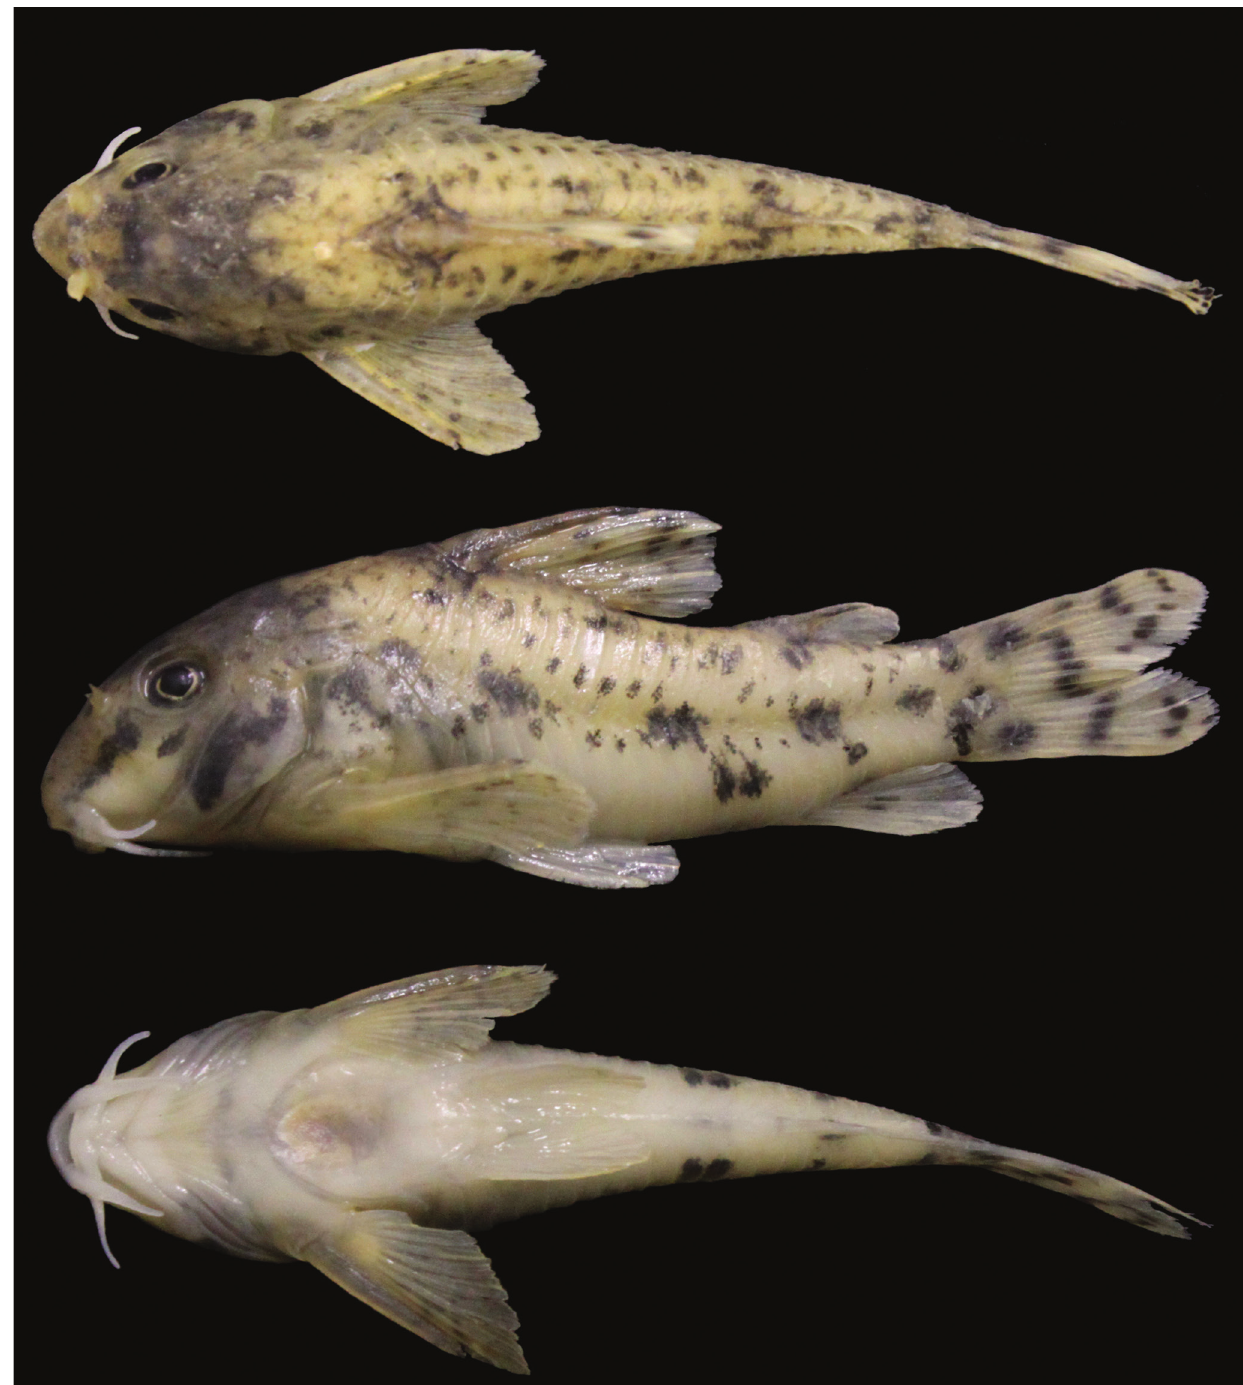
Fig. 1. Corydoras lacrimostigmata , holotype, MNRJ 40725, 31.8 mm SL, Brazil, Paraná, Cândido Abreu, rio Maria Flora, tributary to rio Ubazinho, rio Ivaí basin. Dorsal, lateral and ventral